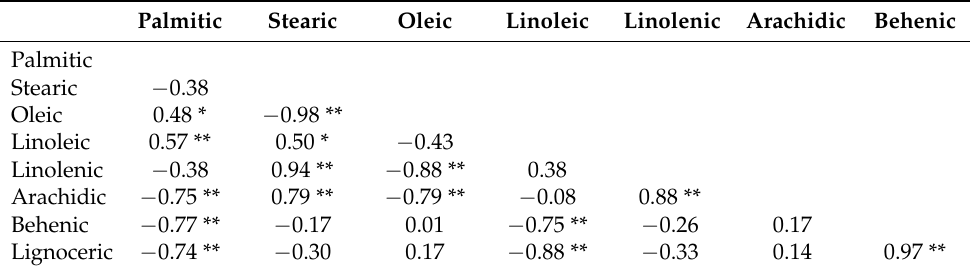
Table 4. Pearson’s correlation coefficients for the fatty acids in honeybee pollen loads. Palmitic